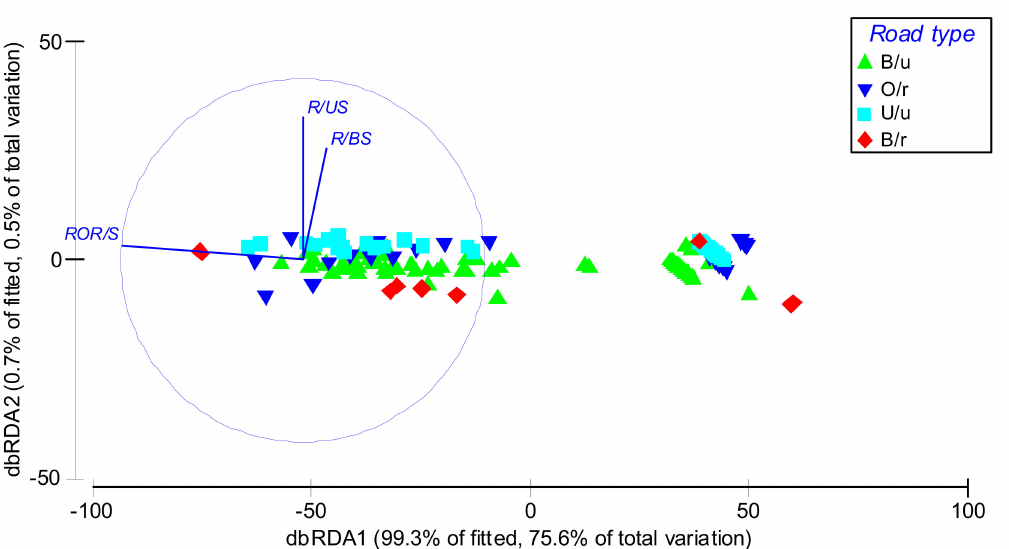
Figure 5. Biplots of distance-based redundancy analysis (dbRDA) applied to erosion volumes measured in rills of four road types in Hell í n (Central-Eastern Spain). Legend: R/US = Road Upstream Slope; R/BS = Road Bare Soil; ROR/S = Rill-On-Road Slope; B/u = Unpaved road in burned forest; B/r = Rock-paved road in burned forest; U/u = Unpaved road in unburned forest; U/r = Rock-paved road in unburned